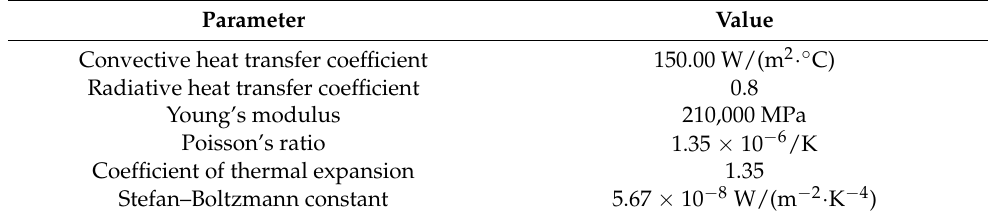
Table 3. Parameters of the boundary